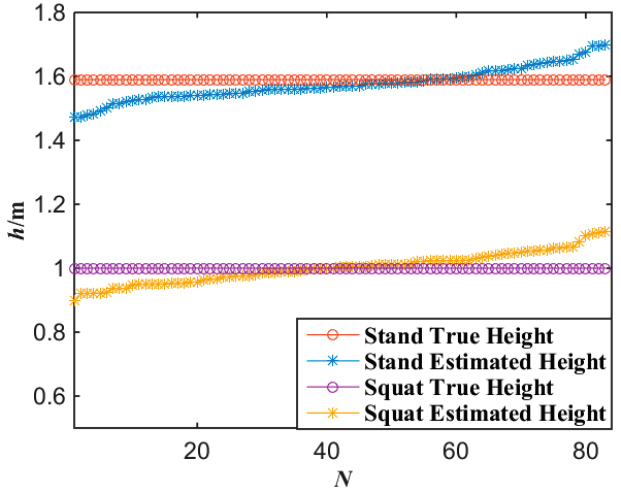
Figure 13. Experimental data of altitude with the miner’s lamp video collaborative